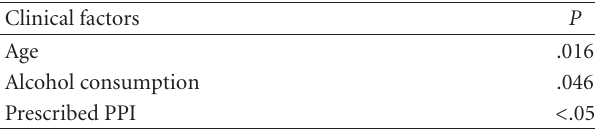
Table 4: Clinical factors of higher eradication rate in the study. Clinical factors P Age .016 Alcohol consumption .046 Prescribed PPI <